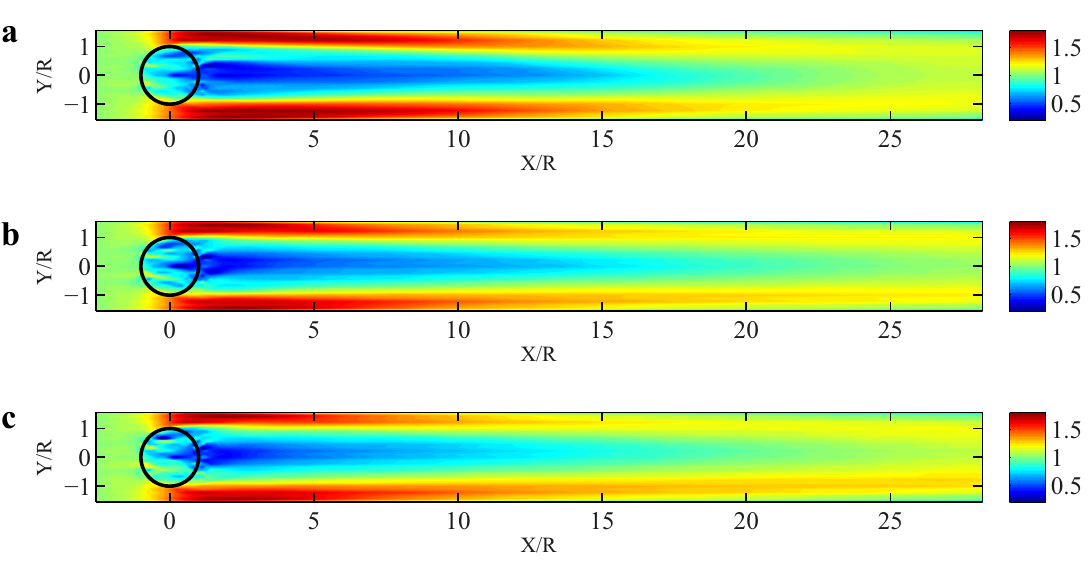
, in a horizontal plane 0